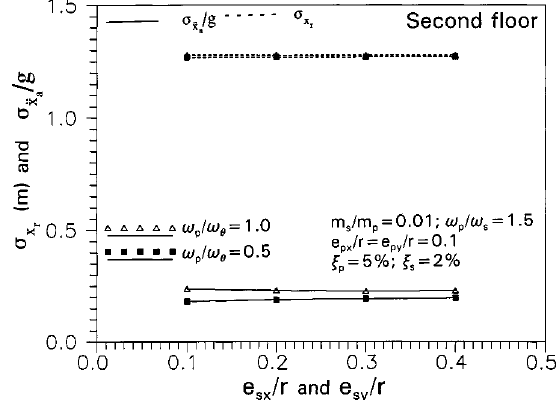
=g with (cid:24) s ; for second floor Fig. 19. Variation of (cid:27) x and (cid:27) (cid:127) x r a level, for ! p =! s = 1.5; ! p =! (cid:18) = 1.0 and 0.5; (cid:24) p = 5% e p x =r = e p y =r = 0.1, e s x =r = e s y =r = 0.3 and m s =m p =